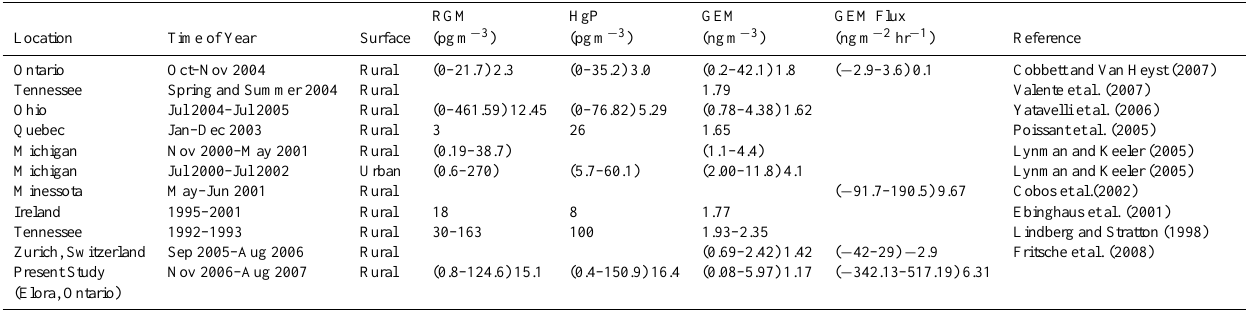
Table 1. Published mercury species concentrations and GEM fluxes measured from terrestrial